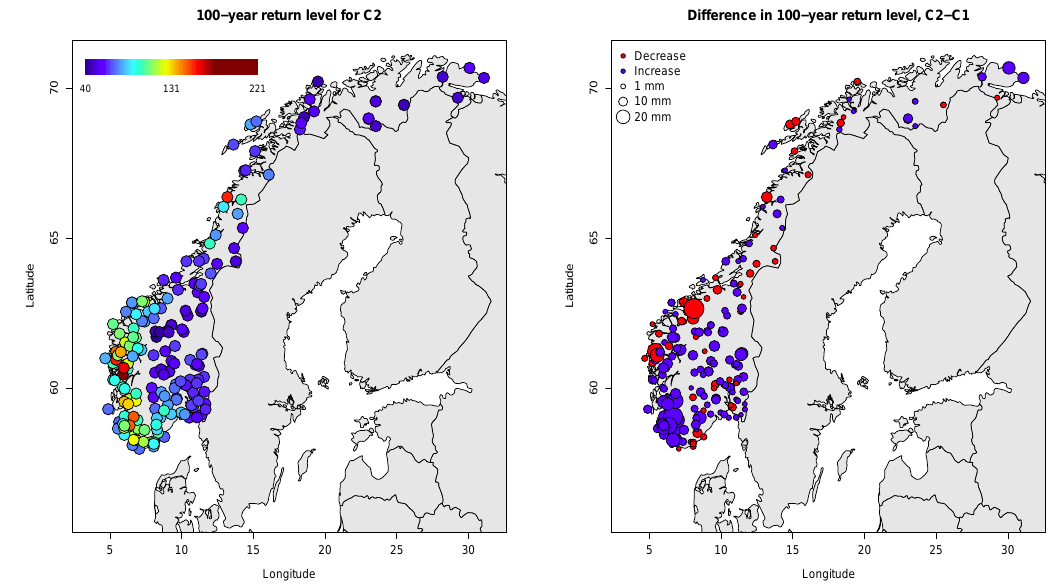
Figure 12. Left: map of 100-year return level estimated on C ( 2 ) (1979–2009) with MEWP ( 0 . 5 , 2 , 8 ) . Right: difference in 100-year estimated on C ( 1 ) and C ( 2 )